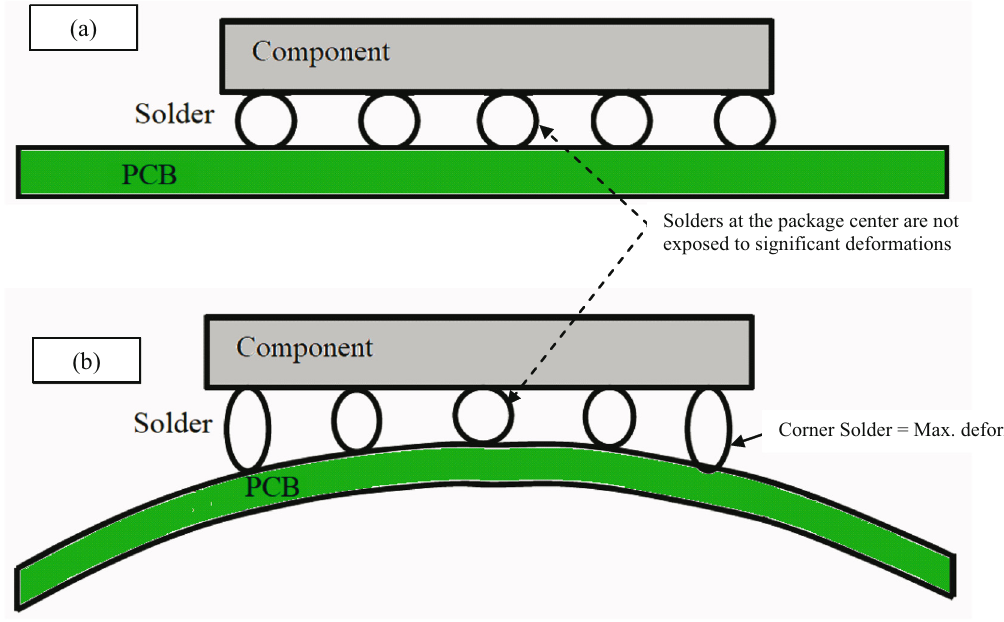
Figure 7: Schematics for ( a ) nondeformed and ( b ) deformed electronic package after bending due to